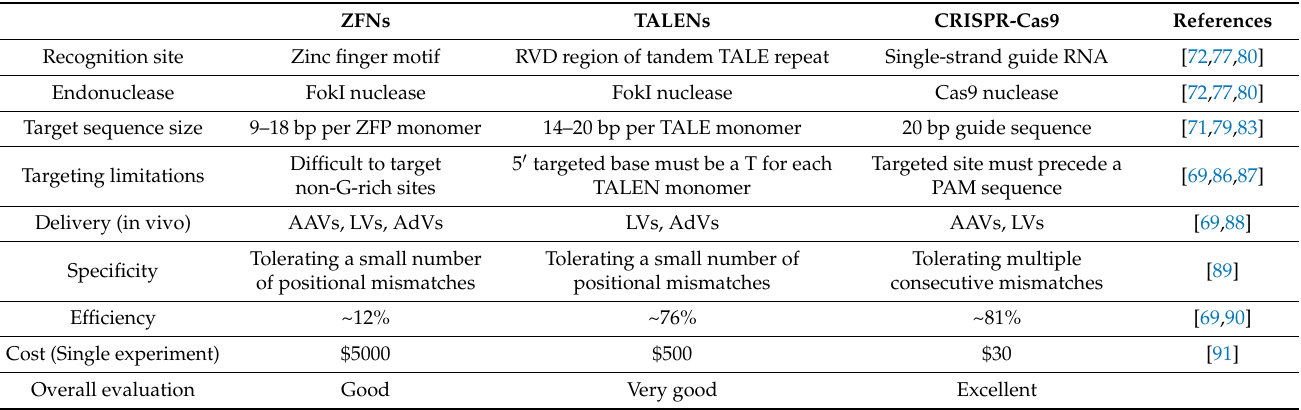
Table 2. Comparison of ZFNs, TALENs and CRISPR-Cas9.